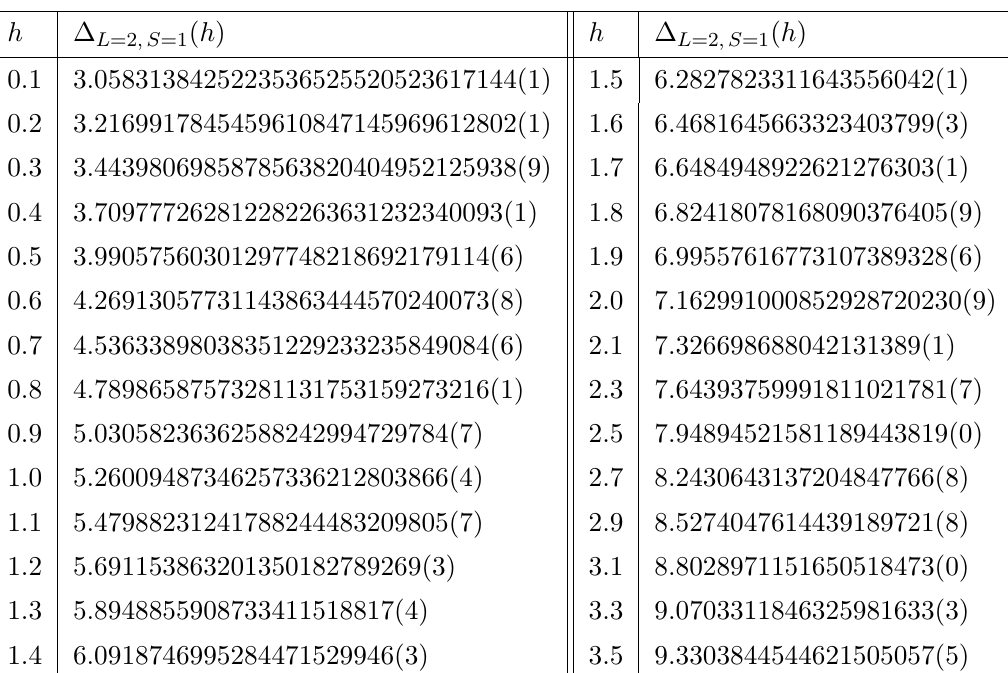
Table 8 . Numerical results for (cid:1) L =2 ;S =1 ( h ) (with u 4 6 = u (cid:22)4